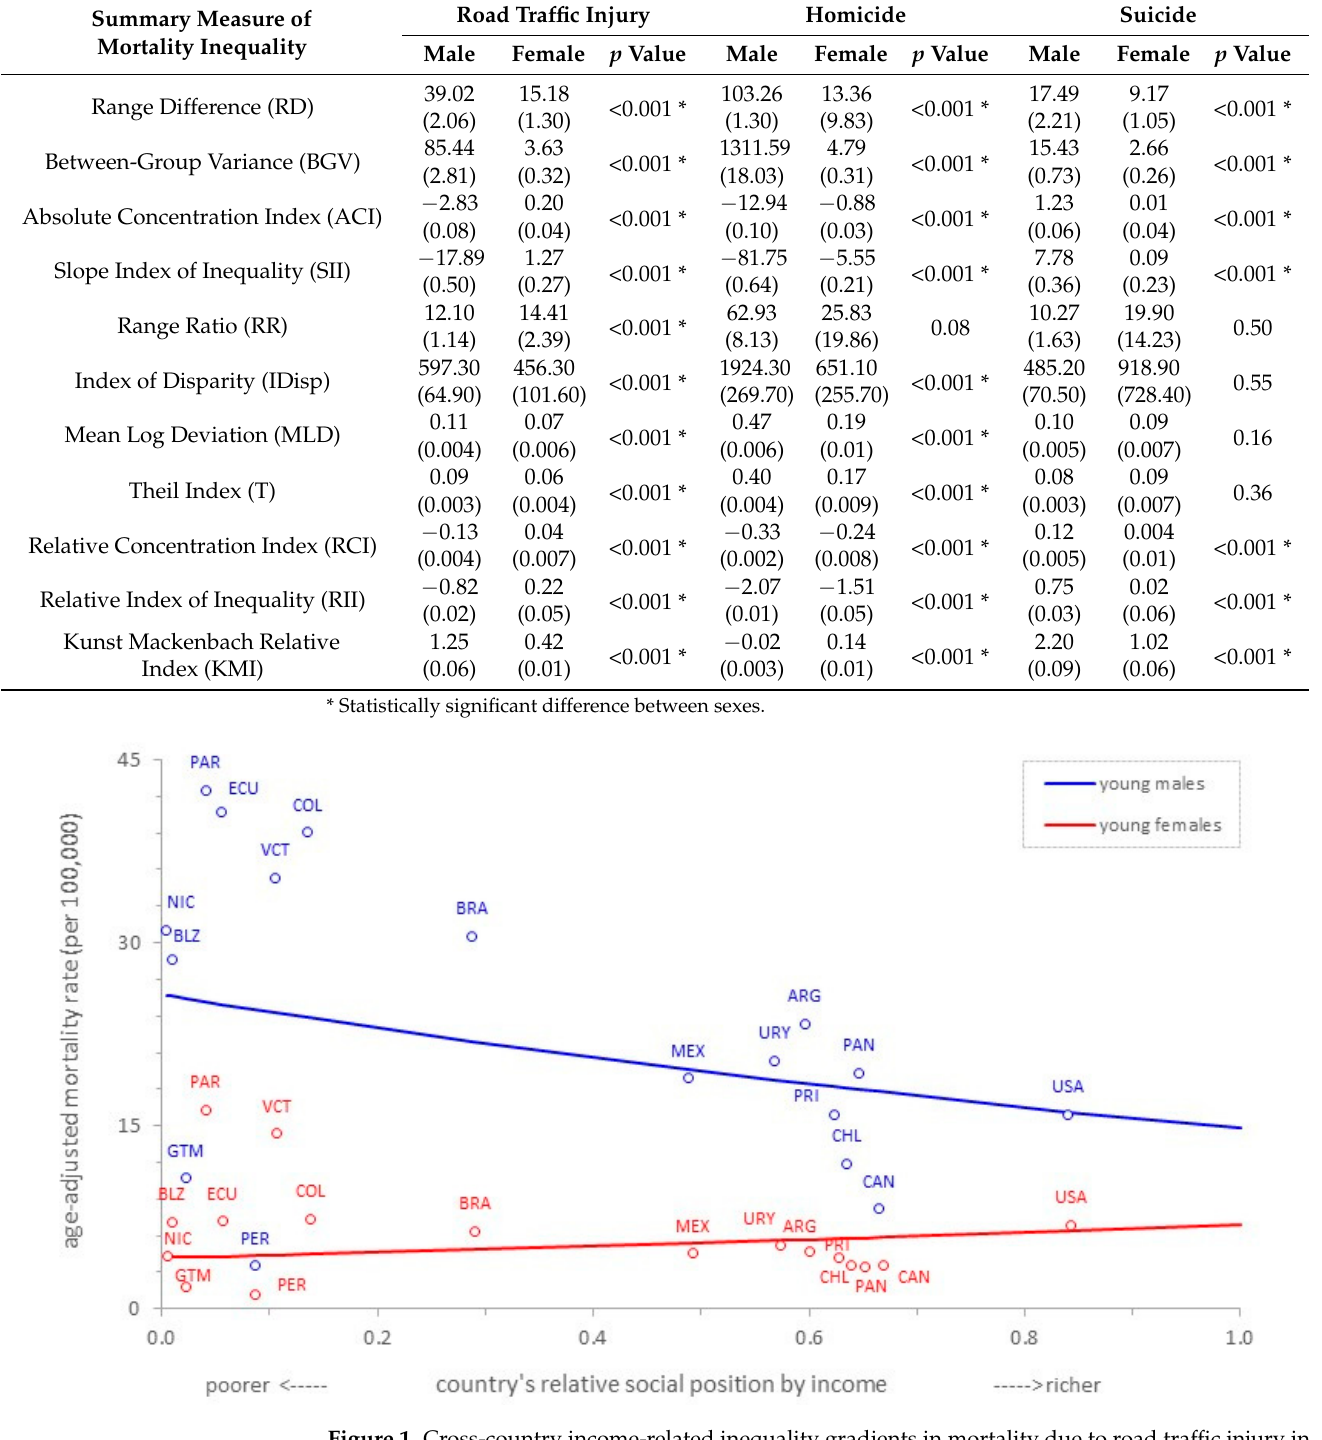
Figure 1. Cross-country income-related inequality gradients in mortality due to road traffic injury in young (10–24 years old) males and females. Region of the Americas, 2015.